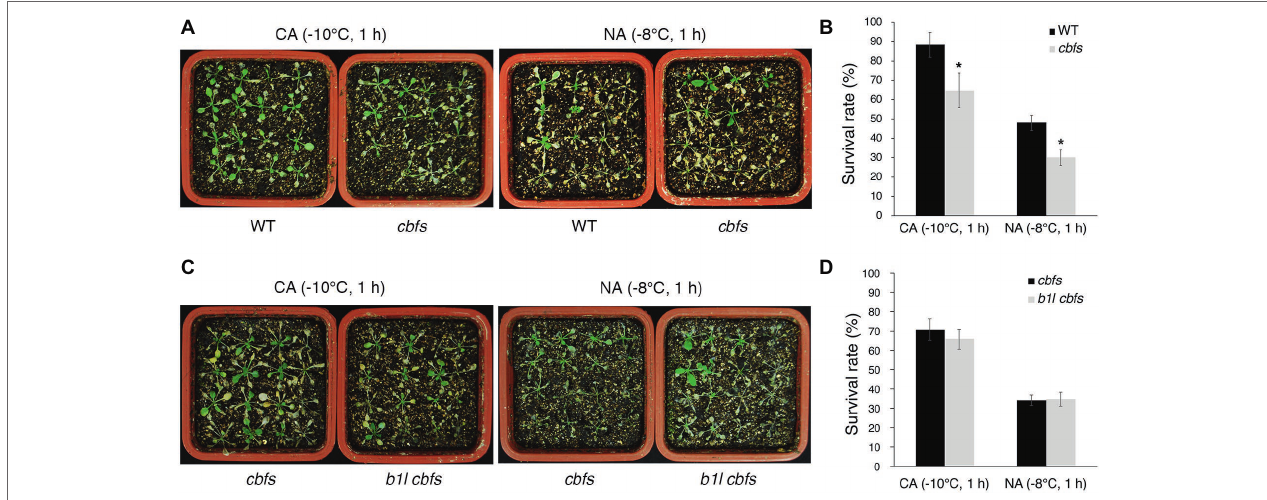
FIGURE 8 | B1L acts upstream of CBFs to regulate cold signaling. Freezing tolerance (A,C) and survival rates (B,D) of cbfs mutants and b1l cbfs mutants under NA or CA conditions. The assays were performed as in Figure 1 . The data are shown as means of three independent biological replicates ± SD. Asterisks indicate significant differences (* p < 0.05) from wild type.